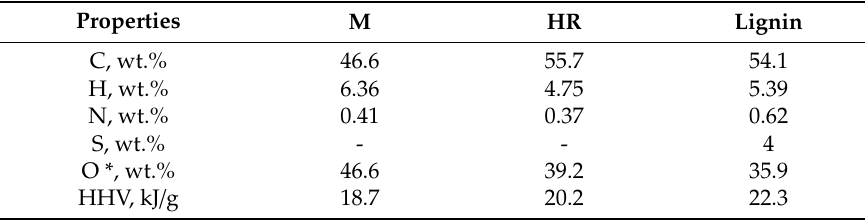
Table 2. Selected surface properties of studied catalysts.